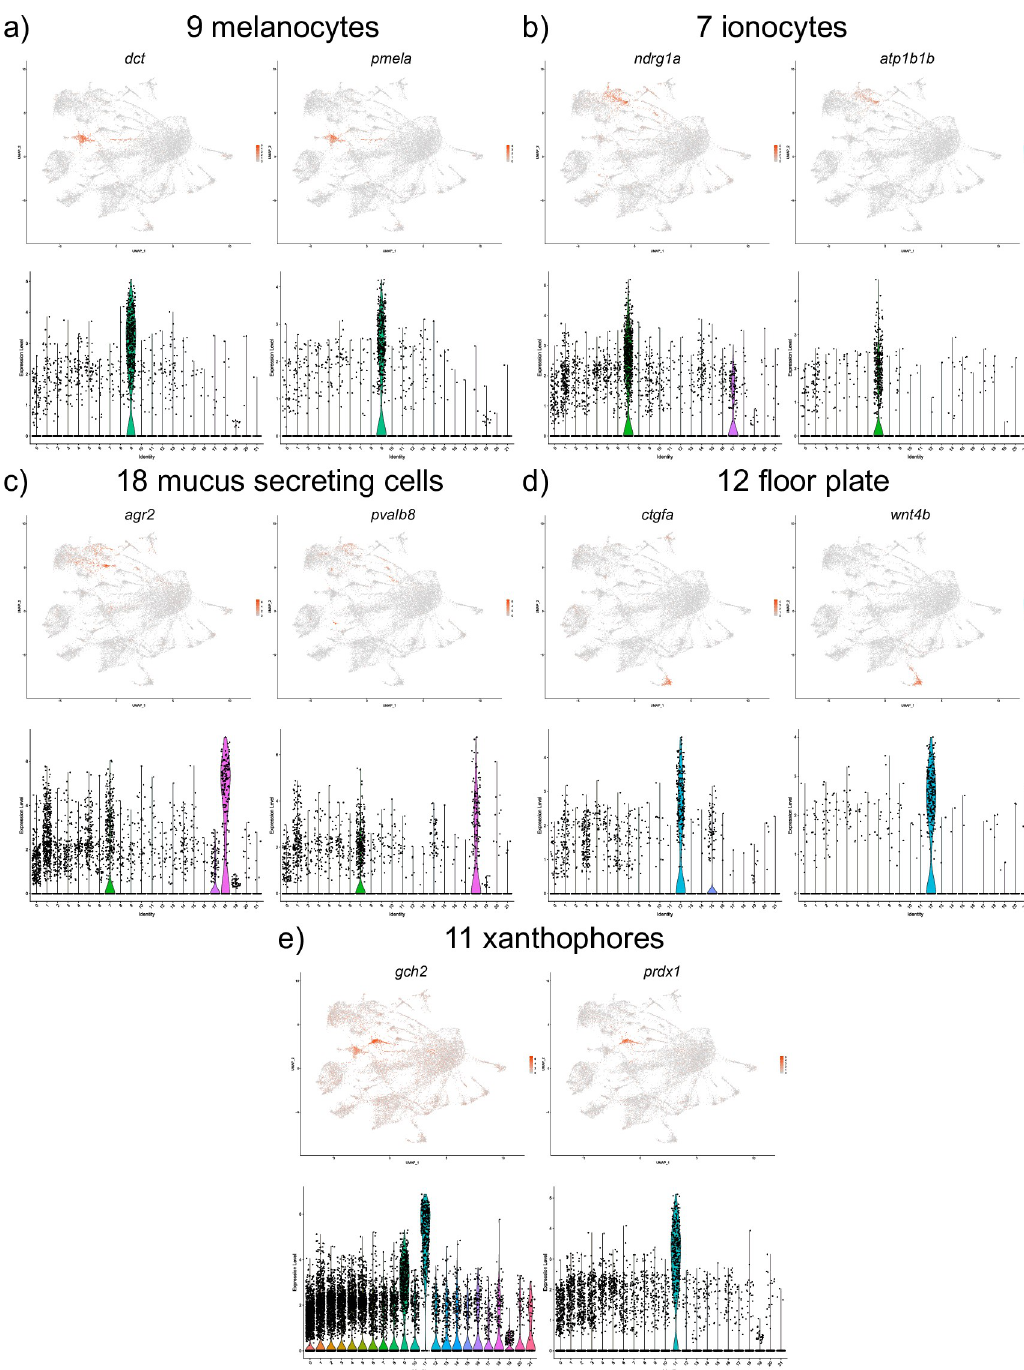
Fig 5. UMAP and violin plots showing the expression of selected marker genes for melanocytes (cluster #9, a), ionocytes (cluster #7, b), mucus secreting cells (cluster #18, c), floor plate (cluster #12, d) and xanthophores (cluster #11, e).